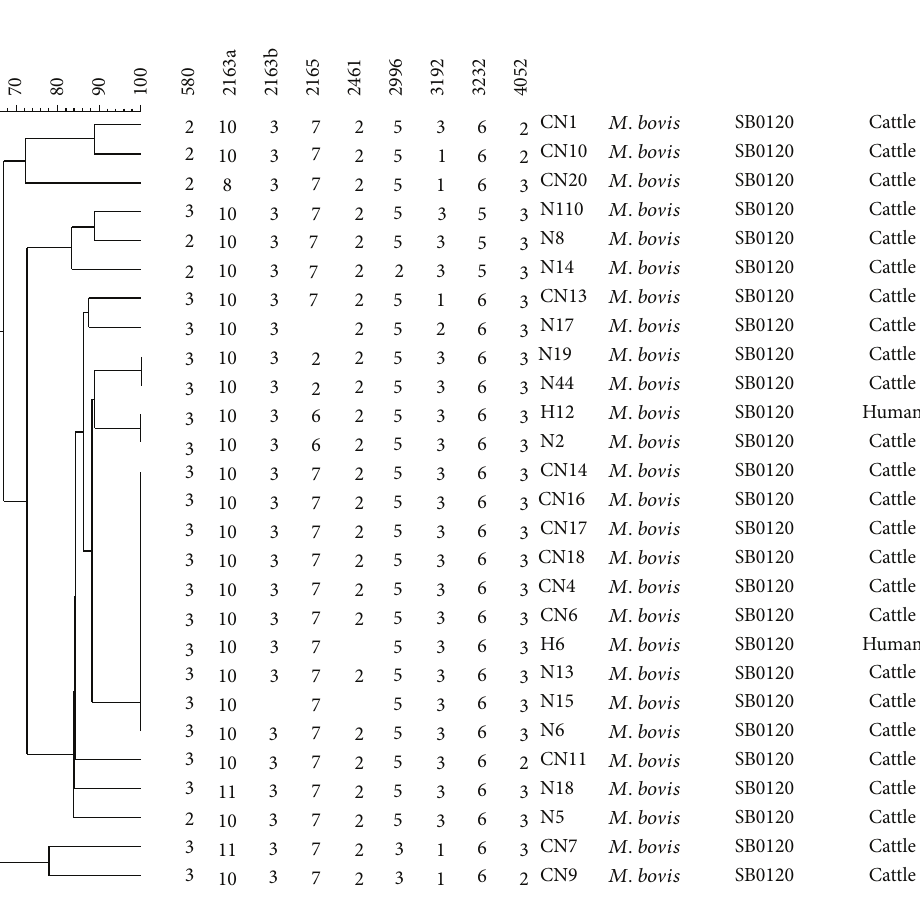
Figure 1: Clustering of representative M. bovis isolates from Namwala district in Zambia based on 9-loci MIRU-VNTR. The dendrogram was generated using Bionumerics 6.1 version